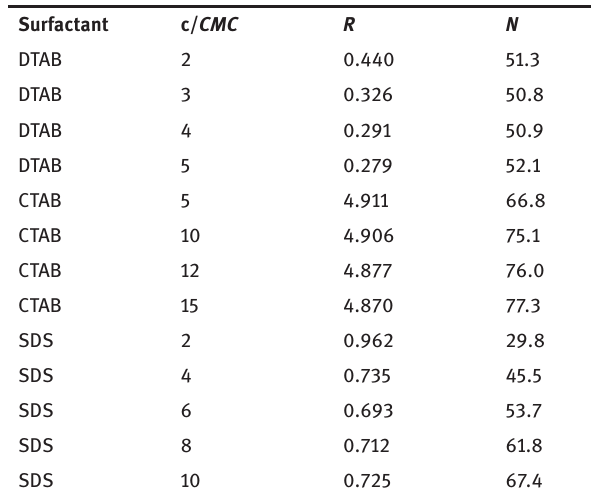
Table 1: Values of fitting parameter R , micelle aggregation number N as a function of surfactant concentration c/CMC for DTAB, CTAB and SDS surfactants determined from fluorescence decay measurements at the excitation wavelength 381